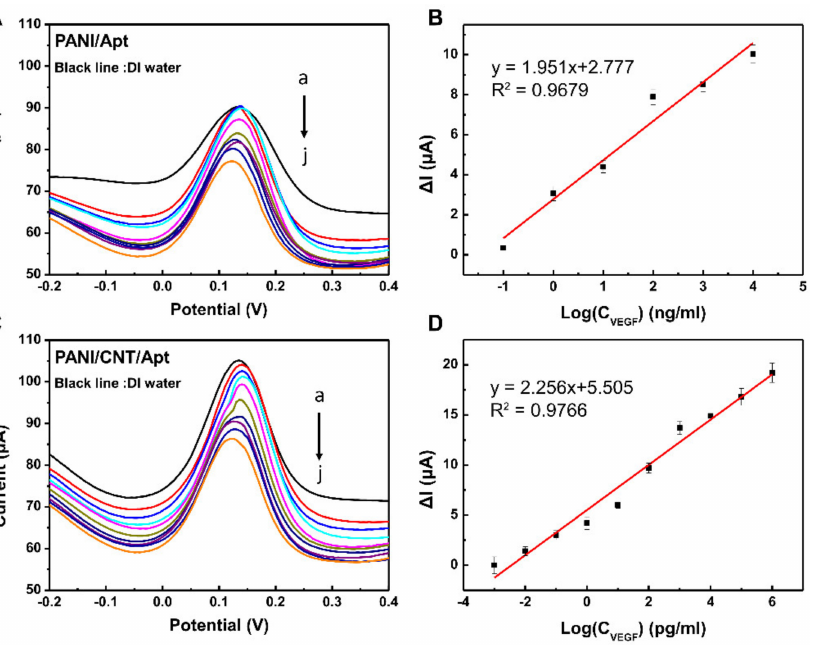
Figure 6. ( A , C ) Differential pulse voltammetry (DPV) plot, at range from − 0.2 V to 0.4 V with a 5 mV height and 50 ms pulse width (step height: 5 mV and step time: 500 ms), of VEGF 165 at different concentrations (from a to j): (reference black line: DI water) 10 fg/mL, 100 fg/mL, 1 pg/mL, 10 pg/mL, 100 pg/mL, 1 ng/mL, 10 ng/mL, 100 ng/mL, 1 µ g/mL, and 10 µ g/mL under the optimized conditions on the PANI/Apt- and PANI/CNT/Apt-modified electrodes. ( B , D ) Peak currents vs. log VEGF concentrations from the DPV plots.